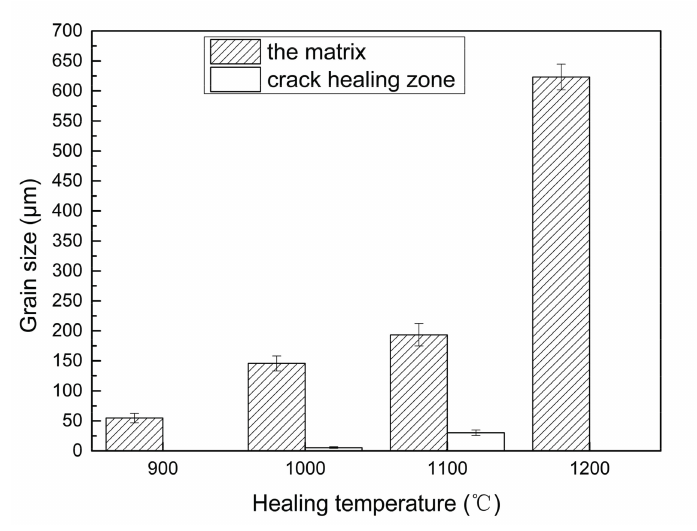
Figure 5. Grain sizes of the matrix and crack healing zone at different healing times for 60